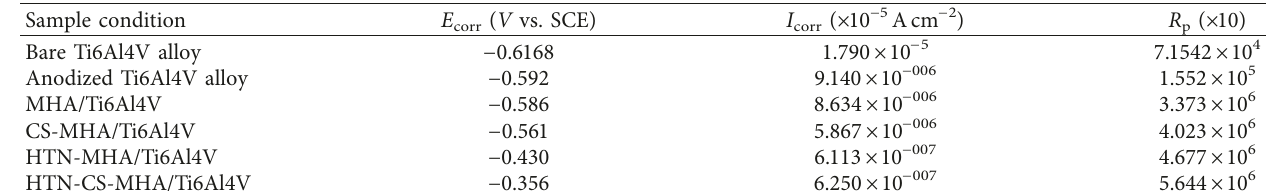
Table 2: Electrochemical parameters of uncoated and coated Ti6Al4V alloy.